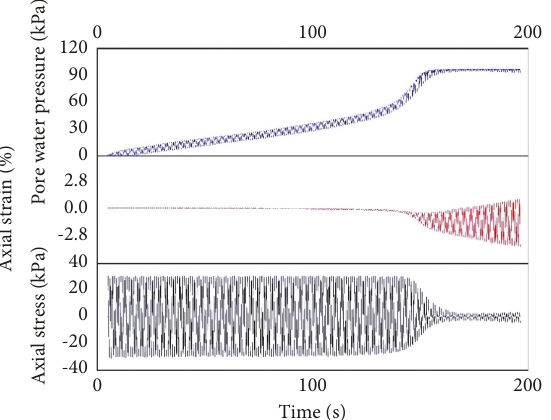
Figure 3: Time history curve of stress, strain, and pore pressure.